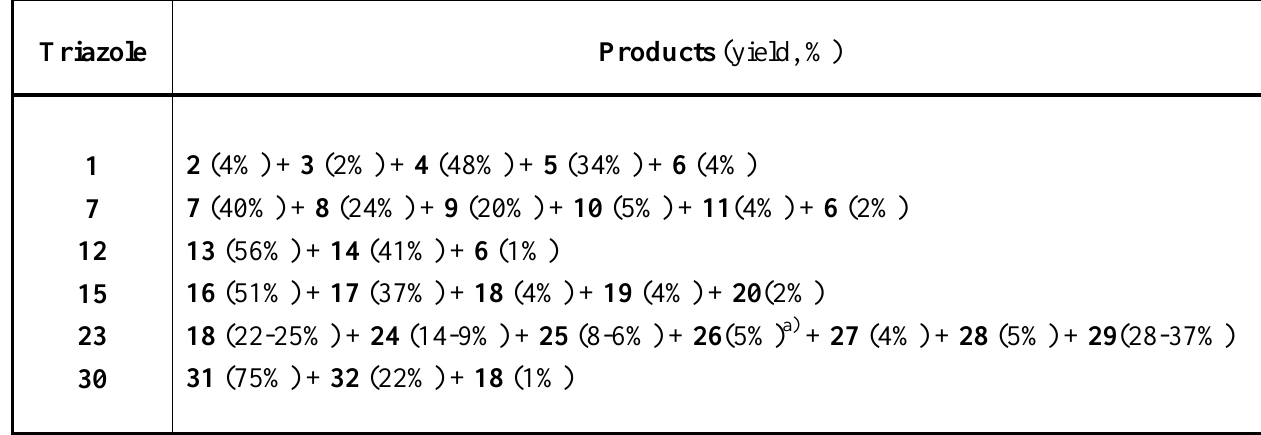
Table 1. Products formed by thermolysis at 320 o C of the neat allyl substituted